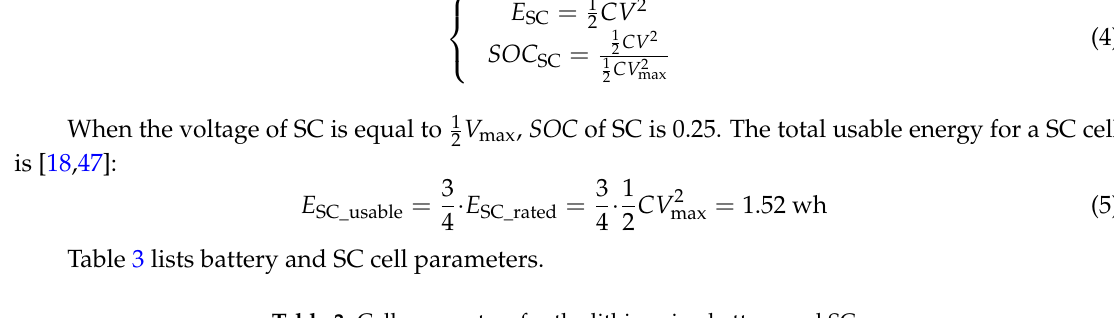
Table 3. Cell parameters for the lithium-ion battery and